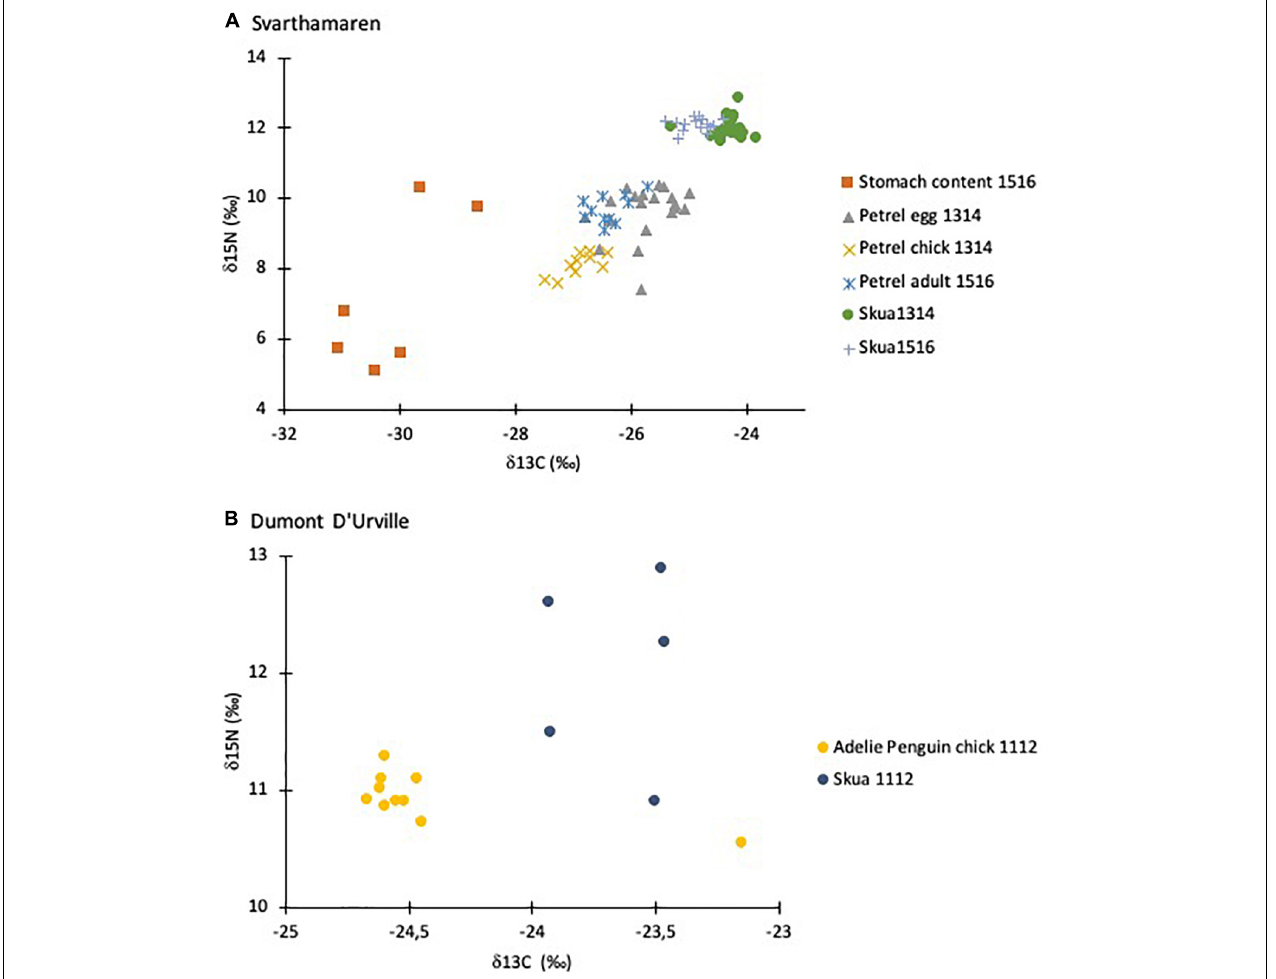
FIGURE 3 | Stable isotope values of carbon ( δ 13 C) and nitrogen ( δ 15 N) of the Svarthamaren food web, Dronning Maud Land (A) and Dumont d’Urville, Adélie Land (B) in Antarctica. The two stomach contents with higher values of δ 13 C and δ 15 N were the ones with perfluoroundecanoate (PFUnA) concentrations quantified above the limit of detection. The arrows indicate the stomach sample (red) with detectable PFAS levels and the adult it was collected from